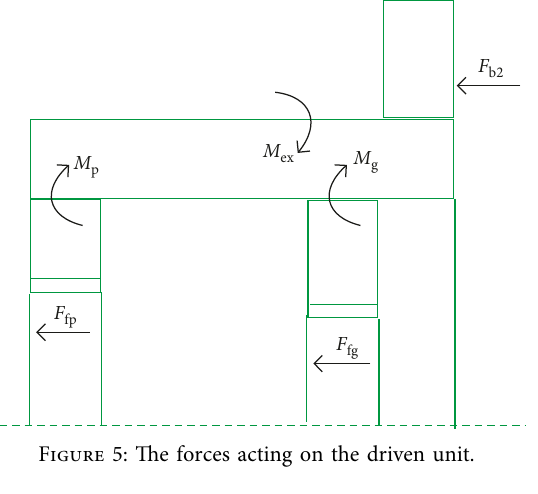
Figure 5: The forces acting on the driven